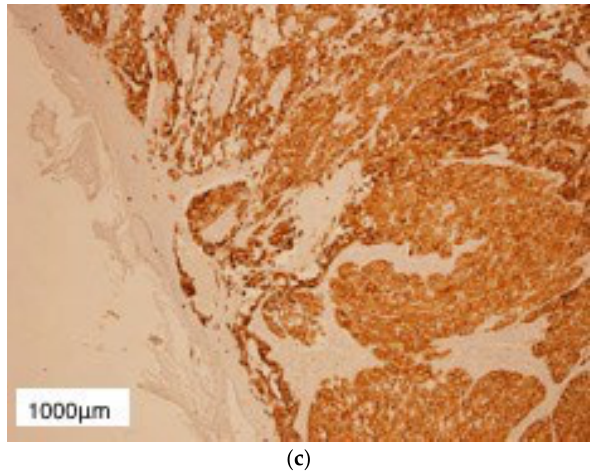
Figure 5. Microphotographs of malignant melanoma sections in our case. ( a ) Immunohistochemical stain (10×) positive for S100; ( b ) Immunohistochemical stain (10×) positive for Ki-67; ( c ) Immunohistochemical stain (10×) positive for Melan-A. Scale bars ( a – c ) images: 1000 μm.